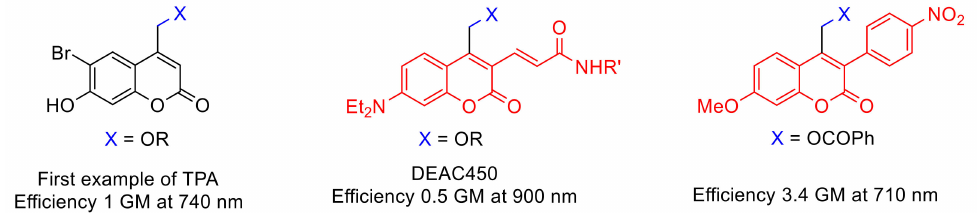
Figure 5. Coumarin-caged compounds undergoing two-photon absorption